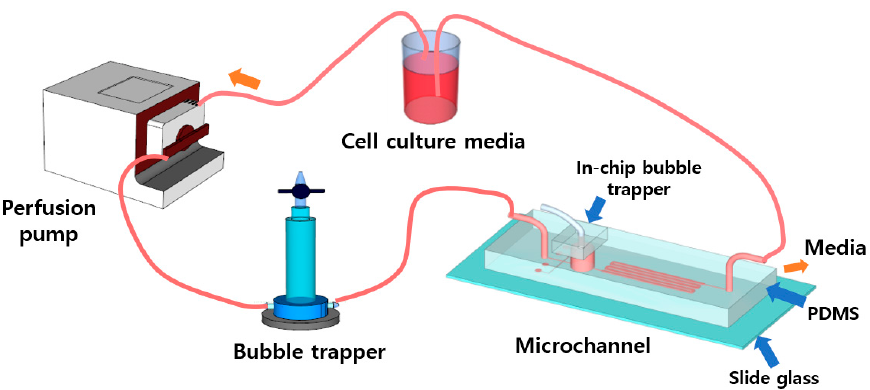
Figure 2. Dynamic cell culture system for virus infection.